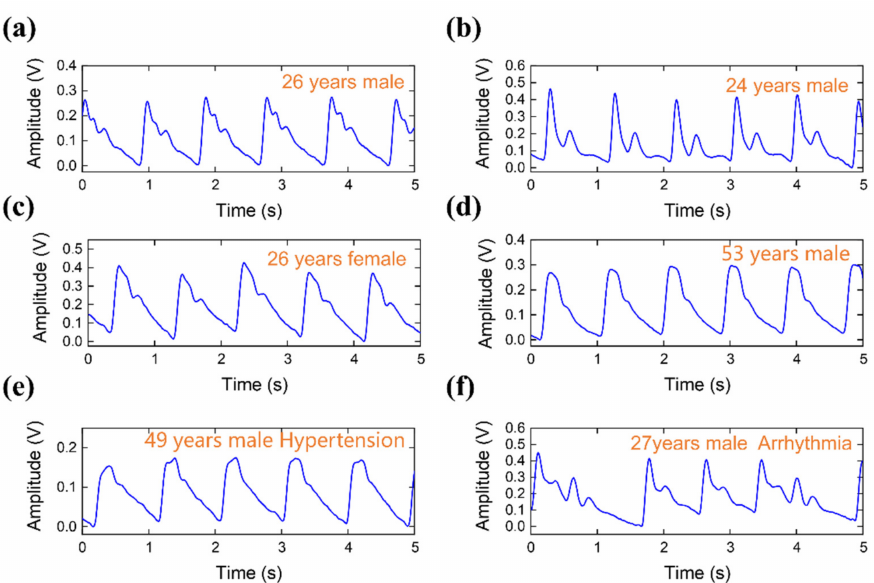
Figure 9. Various pulse waves collected from test subjects with different conditions. Pulse waveforms of ( a ) 26 years male, ( b ) 24 years male, ( c ) 26 years female, ( d ) 53 years male, ( e ) 49 years male with hypertension, ( f ) 27 years male with arrhythmia,